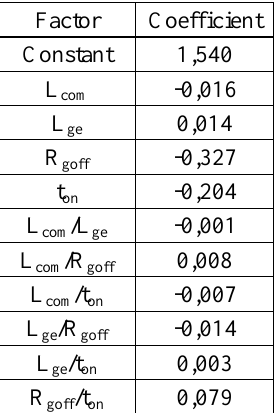
table 4. Table 4: Model’s coefficients